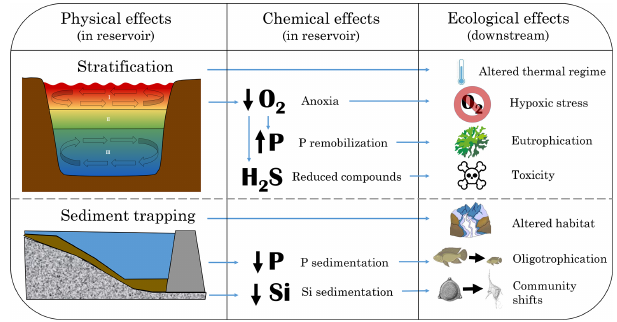
Figure 2. Conceptual summary of the physical and chemical water quality effects of dams and how they affect aquatic